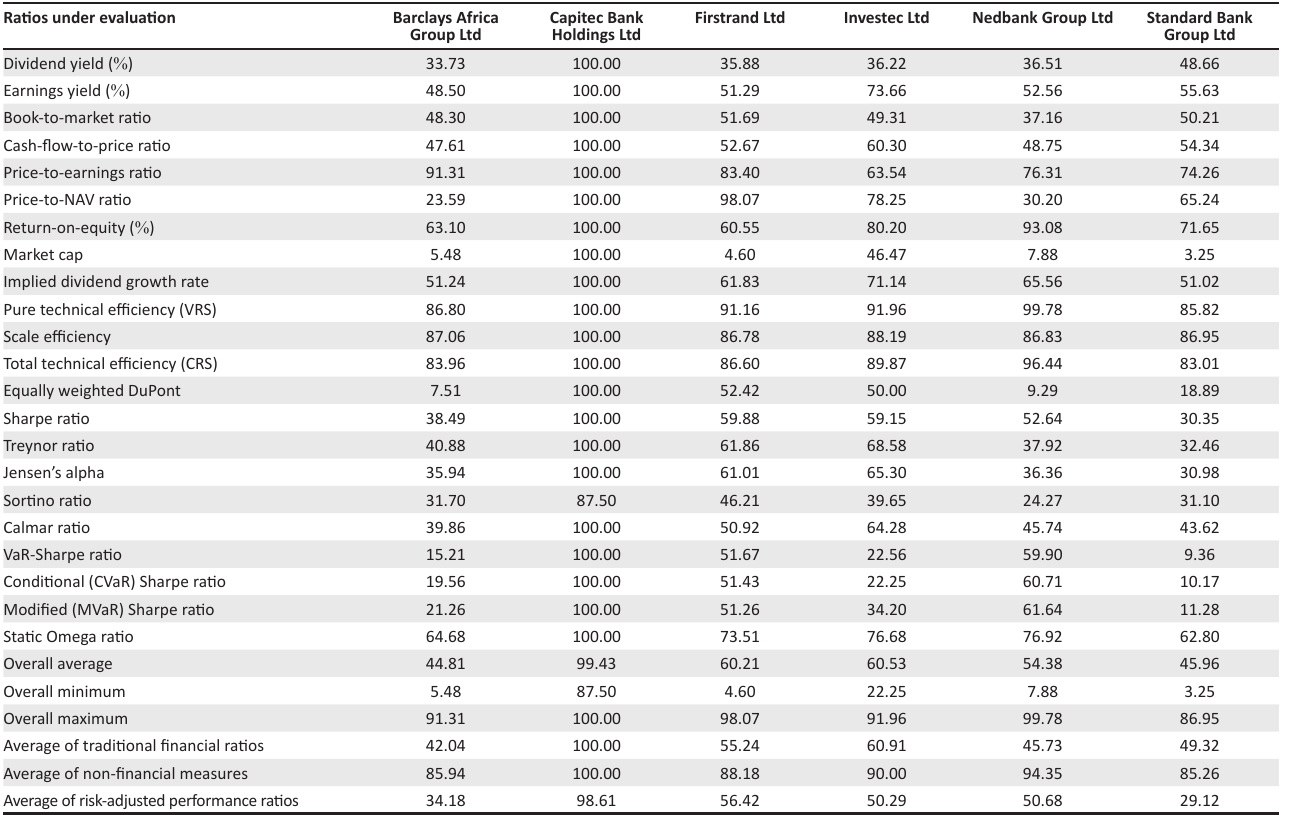
TABLE 7: Average explanatory ability of ratios to explain five years ahead share returns per bank.